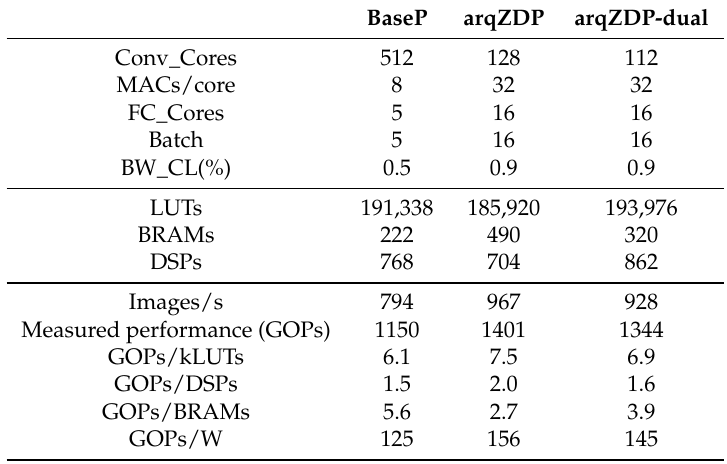
Table 3. Results of the architectures running the inference of AlexNet in a ZYNQ XC7Z045 FPGA.